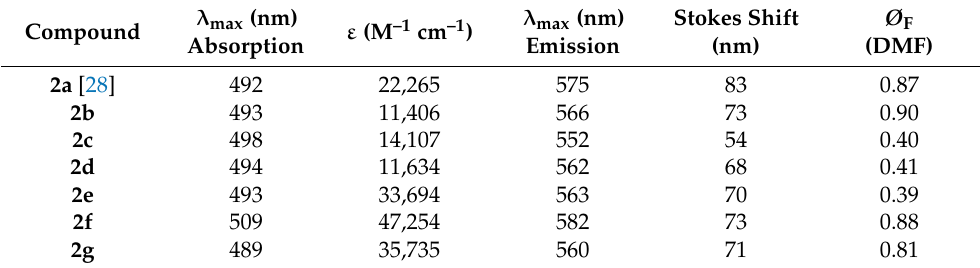
Table 1. Spectroscopic data for compounds 2a – g a